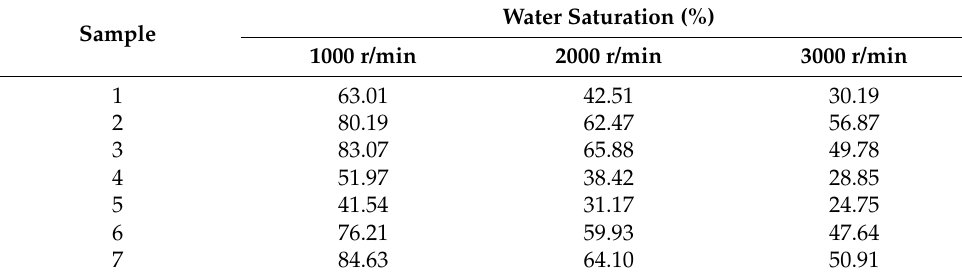
Table 4. Water saturation of samples at different centrifugal